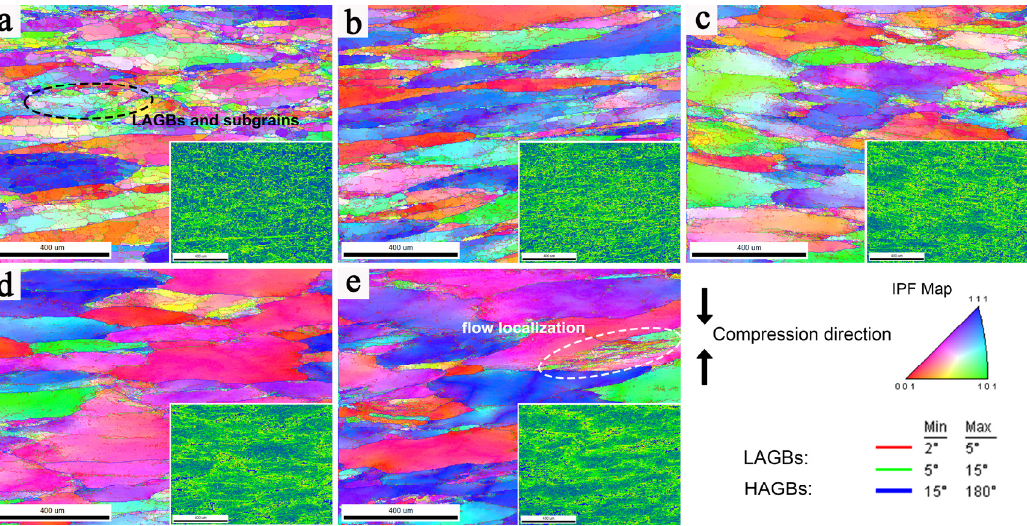
Figure 8. IPF image and KAM maps of the 2198 alloy hot-deformed at di ff erent conditions: ( a ) 510